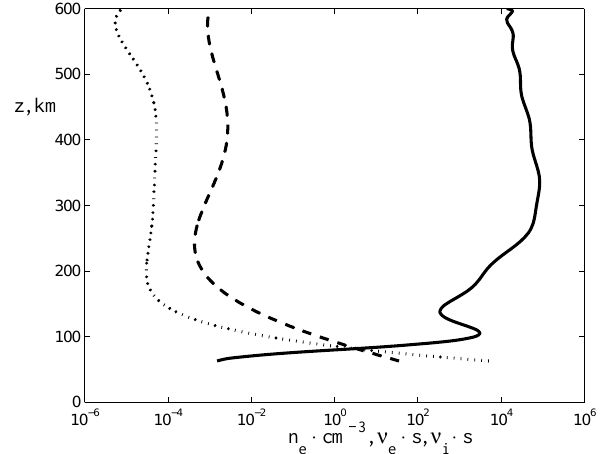
Figure 2. The energy reflection coefficient R and the normalized amplitude of the horizontal magnetic field of the wave on the ground surface h : (a) k x = k y = 0, z ∗ = 125km; (b) k x = 0 . 02km − 1 , k y = − 0 . 02km − 1 , z ∗ = 125km; and (c) k x = 0km − 1 , k y = 0 . 3km − 1 , z ∗ =